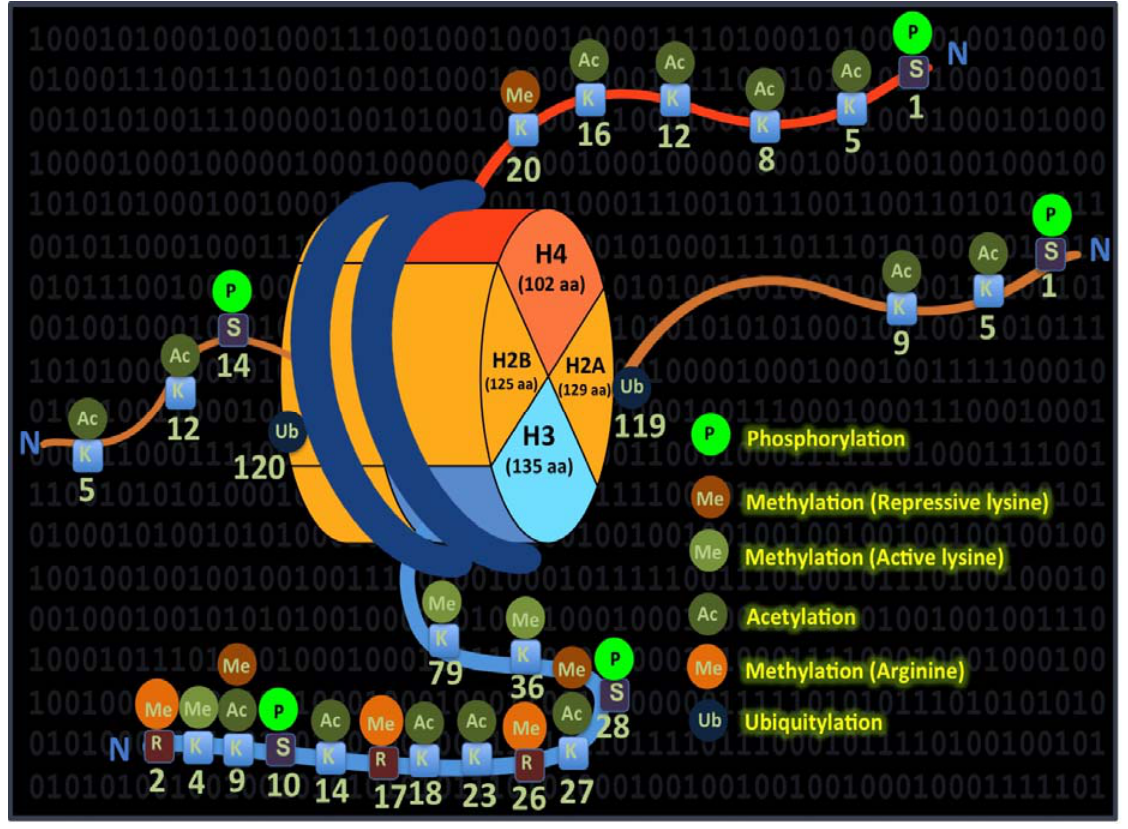
Figure 2. Colorful language of histone modifications and their precise coordination are suggested to constitute a code. Components of the core histones (H2A and B, H3 and H4) and their modifications are indicated in different colors. Together, these dynamic modifications are thought to comprise an imaginary code termed, the “histone code”, which is depicted as binary digits in the